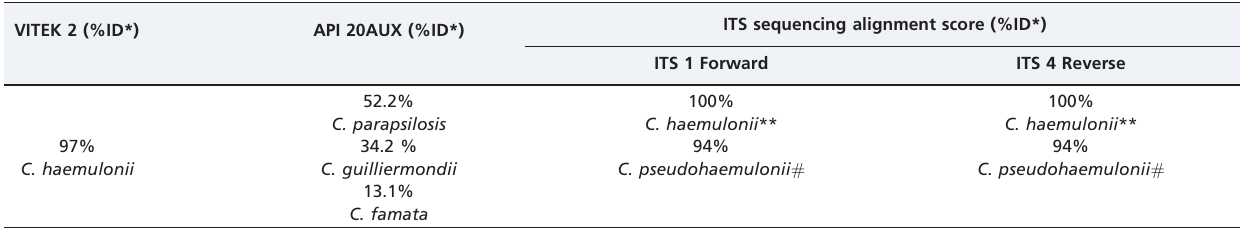
Table 1 - Identification of Candida haemulonii by two commercial biochemical systems and by sequencing analysis. VITEK 2 (%ID*)